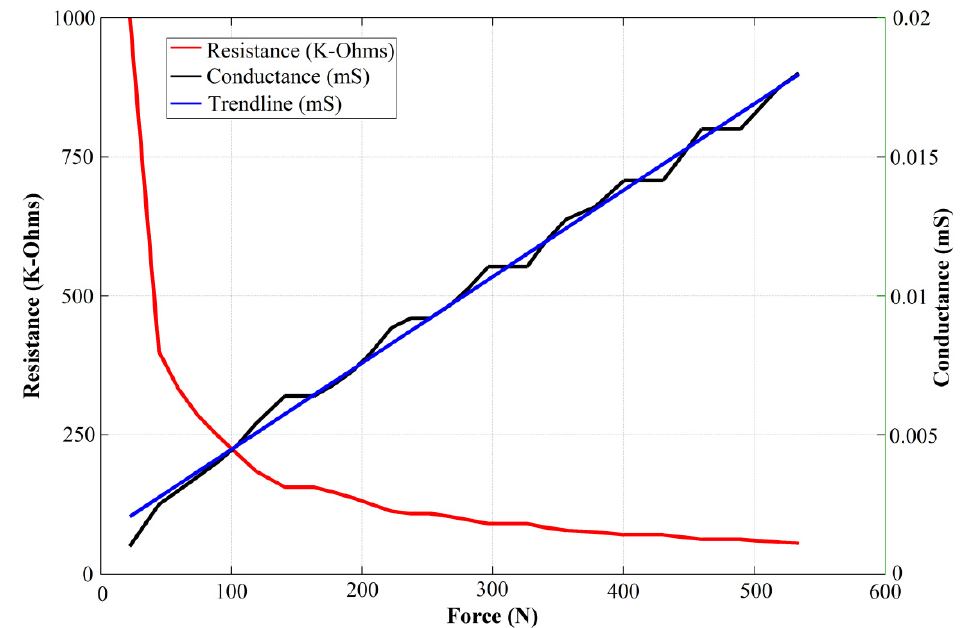
Figure 2. Typical variation of resistance and conductance for an A201-100 FlexiForce sensor (image taken from [25]; the image axis and legend were modified by the authors for better